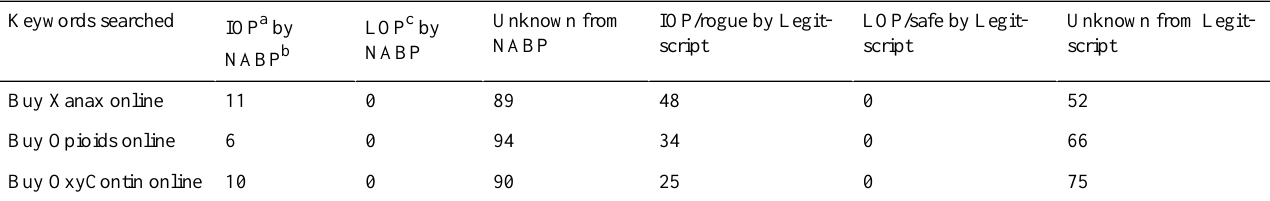
Table 8. Status of the search results according to Legitscript and National Association Board of